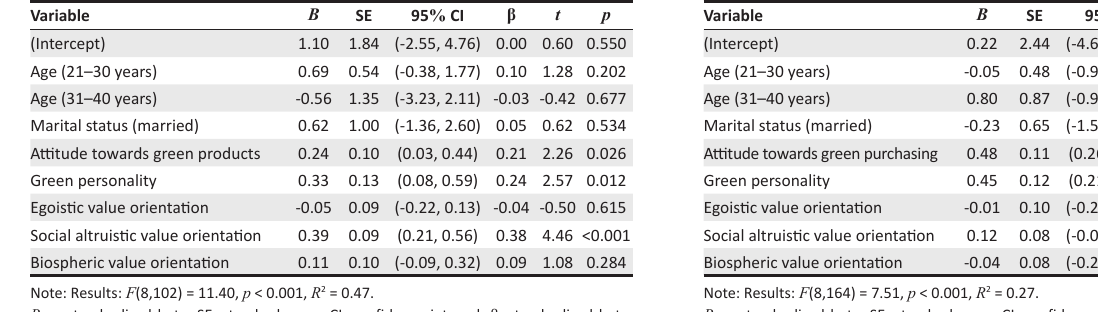
TABLE 4: Independent samples t -test results. Variable Female Male t p d M SD M